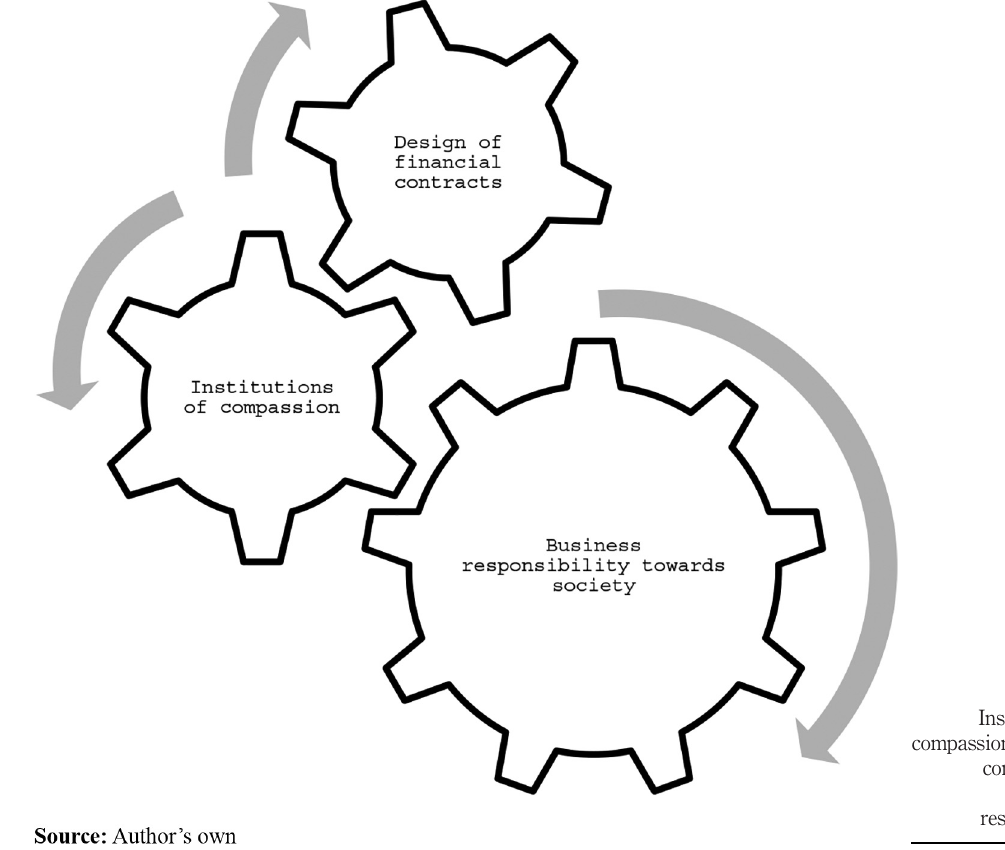
Figure 1. Institutions of compassion, design of contracts and